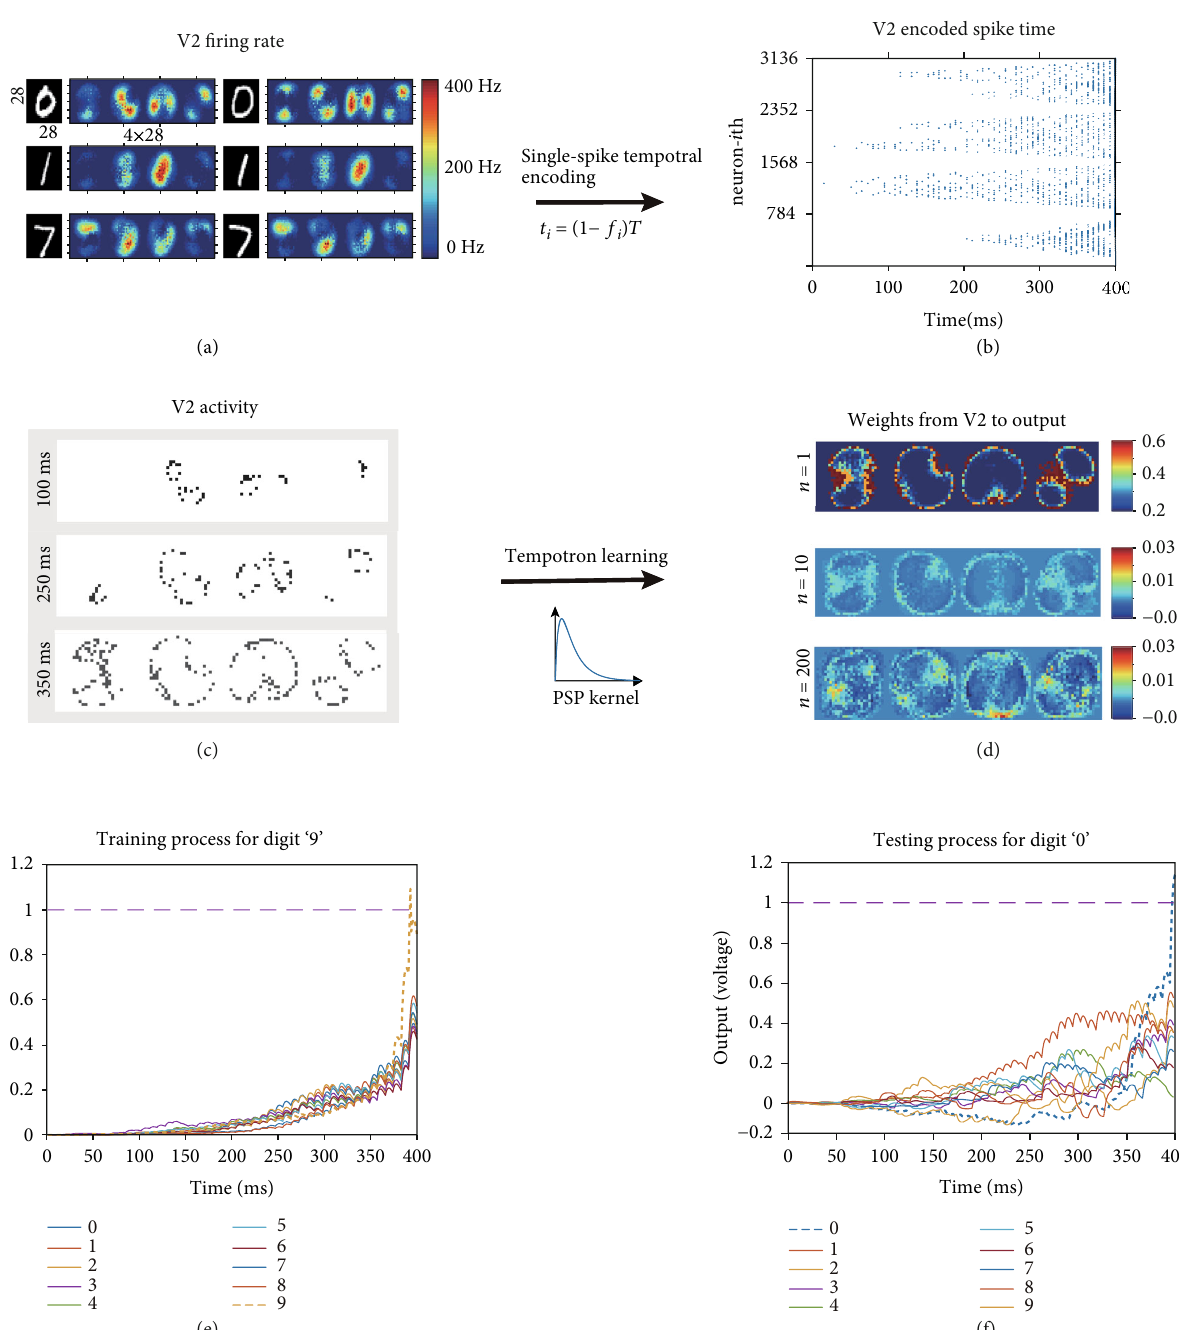
Figure 2: (a) Firing rates of four pool orientation-selective V2 neurons for di ff erent digit images. (b) Spike trains for V2 neurons after t = 100,250,350 ms. (d) Synaptic weights from the V2 layer to the output layer after tempotron learning with n = 1,10,200 training samples for the digit “ 0 : ” Note that fi ring activities of the edge neurons of each pool of the orientation population in V2 as shown in (c) (bottom panel) are quite similar with the weight matrix after learning. (e, f) The voltage accumulations of output neurons during the training and testing process,